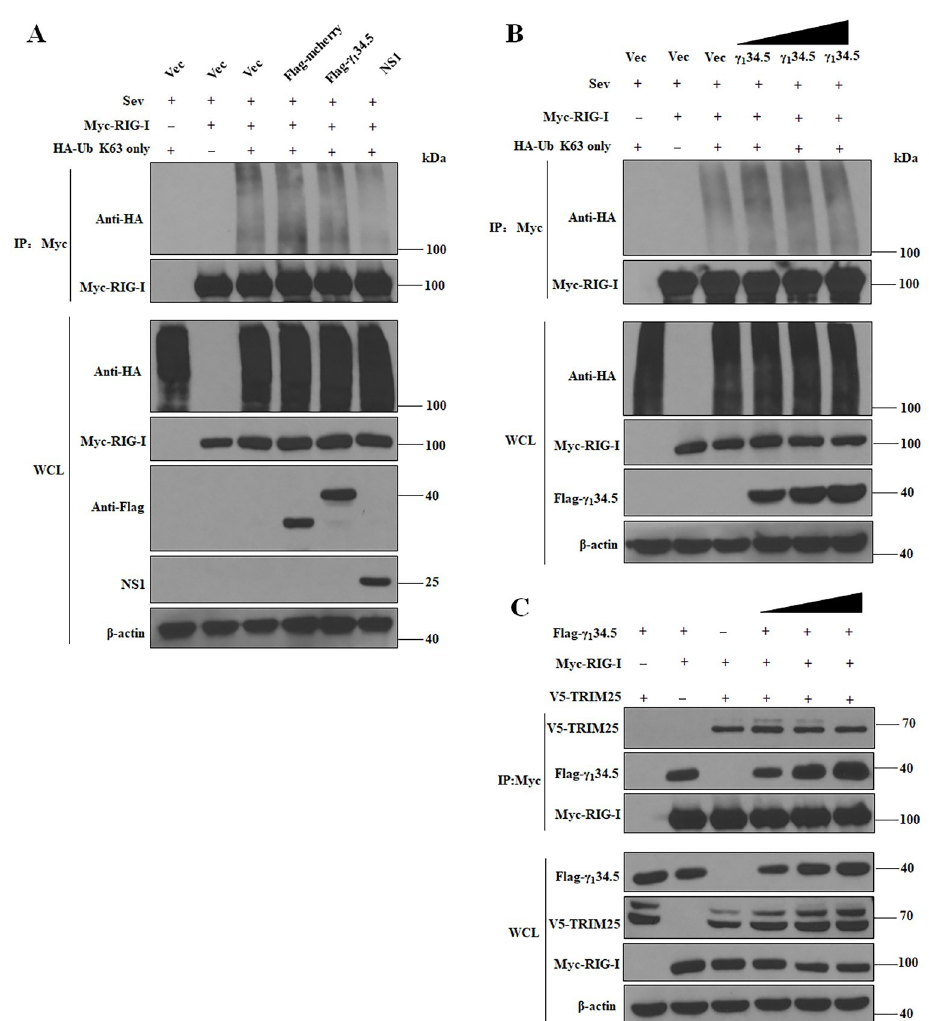
Fig 5. The γ 1 34.5 protein does not inhibit the K63-linked ubiquitination of RIG-I. (A) Effect of γ 1 34.5 on ubiquitination. HEK-293T cells were transfected with plasmids encoding Myc-RIG-I and HA-Ub (K63 only) together with empty vector (Vec), Flag-mCherry, Flag- γ 1 34.5 or pCAGGS-NS1 (positive control). At 24 h after transfection, the cells were treated with SeV (100 HA/ml) for additional 12 h and then harvested for ubiquitination analysis as described in the Materials and Methods. Whole-cell lysates (WCLs) were subjected to immunoprecipitation (IP) with anti-Myc antibody. Precipitated proteins and WCLs were probed with antibodies against HA, Flag, Myc, and β -actin. (B) Effect of different doses of γ 1 34.5 on RIG-I ubiquitination. HEK-293T cells were transfected with increasing amounts of Flag- γ 1 34.5 and assayed as described as in (A). (C) The γ 1 34.5 protein does not disrupt the interaction of RIG-I and TRIM25. HEK-293T cells were transfected with plasmids encoding Myc-RIG-I and V5-TRIM25 together with empty vector (Vec) or different doses of Flag- γ 1 34.5 for 36 h. WCLs were subjected to IP with anti-Myc antibody. Precipitated proteins and WCLs were probed with antibodies against Flag, Myc, V5, and β -actin. The experimental data are representative of results from three independent